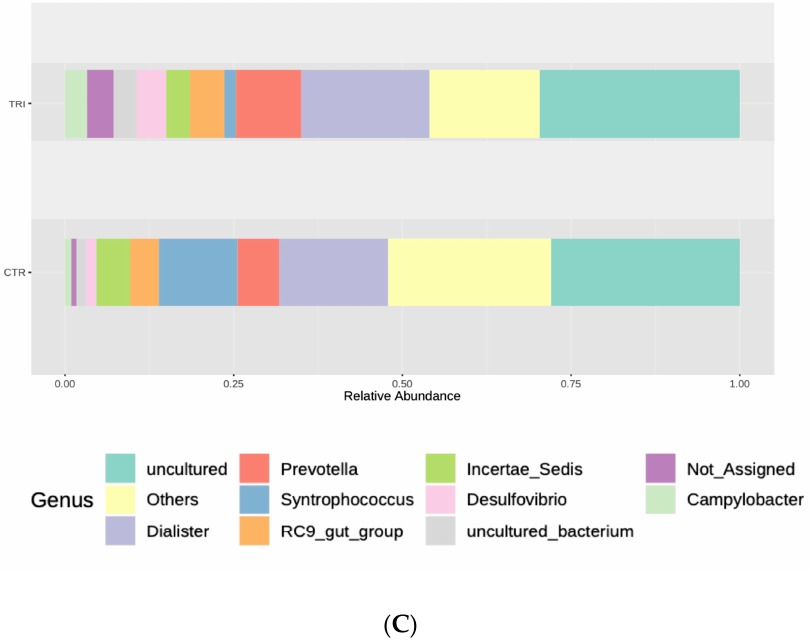
Figure 2. Relative abundances of the different phyla ( A ), families ( B ) and genera ( C ) observed in the tributyrin animal group (TRI) compared with those of the control group (CTR). Only top taxa are shown.